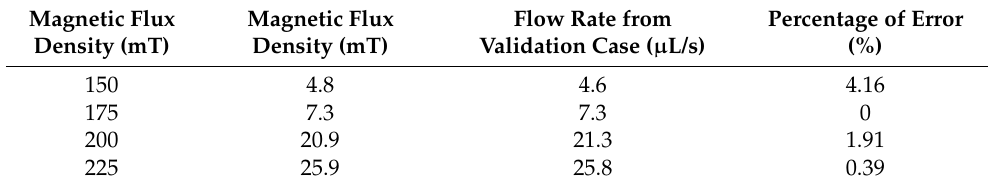
Figure 8. Net pumped volume comparisons between this study and benchmark study [31]. Table 4. Percent error of the flow rates between this study and benchmark study [31].